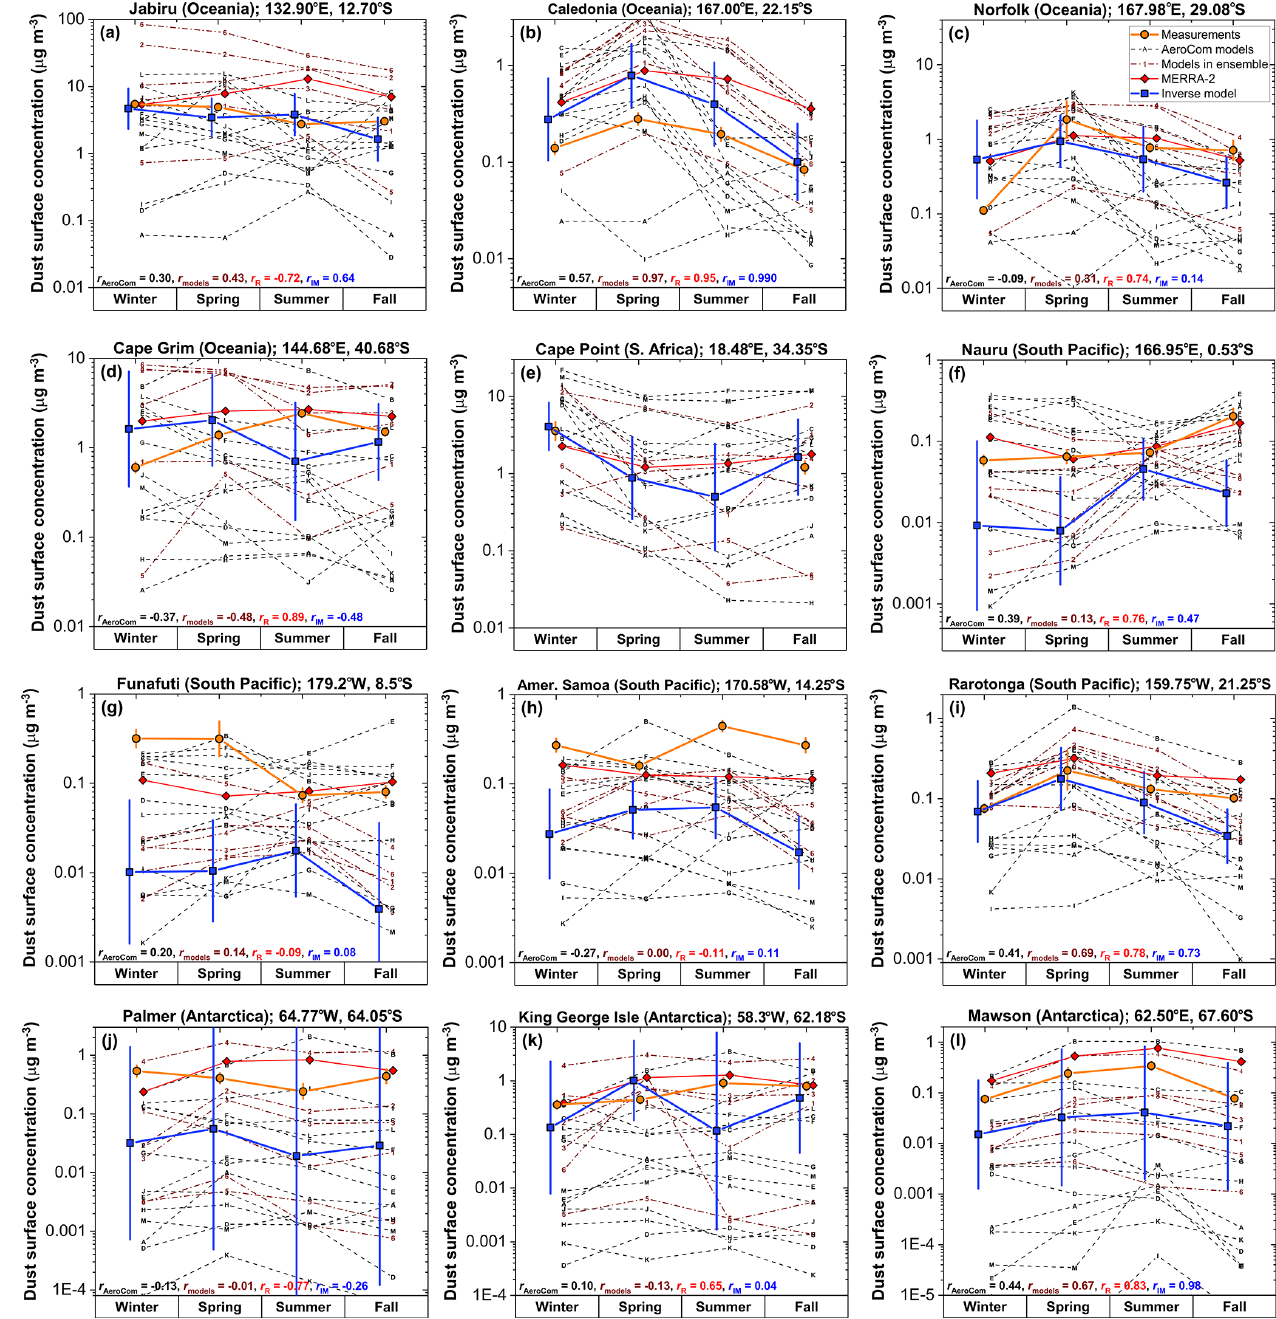
Figure 9. Comparison of measured and modeled seasonally averaged dust surface concentrations at 12 Southern Hemisphere stations. Shown are measurements (orange line and circles) and results from models in the AeroCom ensemble (black dotted lines and symbols) and our ensemble (brown dashed lines and symbols), as well as results from MERRA-2 (red line and diamonds) and the inverse model (blue line and squares). Also shown are the mean correlation coefficients between measurements and the different AeroCom models ( r AeroCom ) and between measurements and the different models in our ensemble ( r models ), as well as the correlation coefficients for MERRA-2 ( r R ) and the inverse model results ( r IM ). Uncertainty ranges for the inverse model results and measurements represent 1 standard error in the climatological seasonally averaged surface concentration. The legend for individual models is given in Fig. 3, and x values are slightly offset for